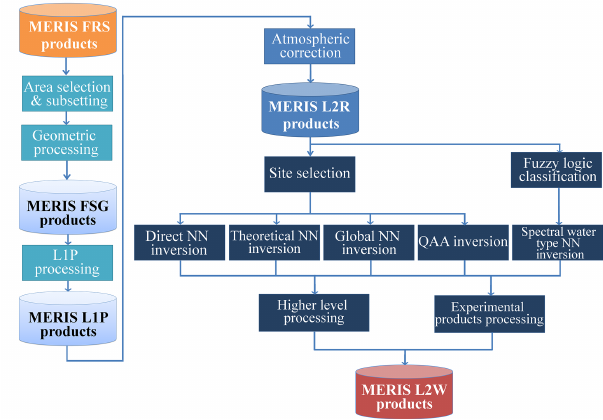
Figure 4. MERIS CoastColour